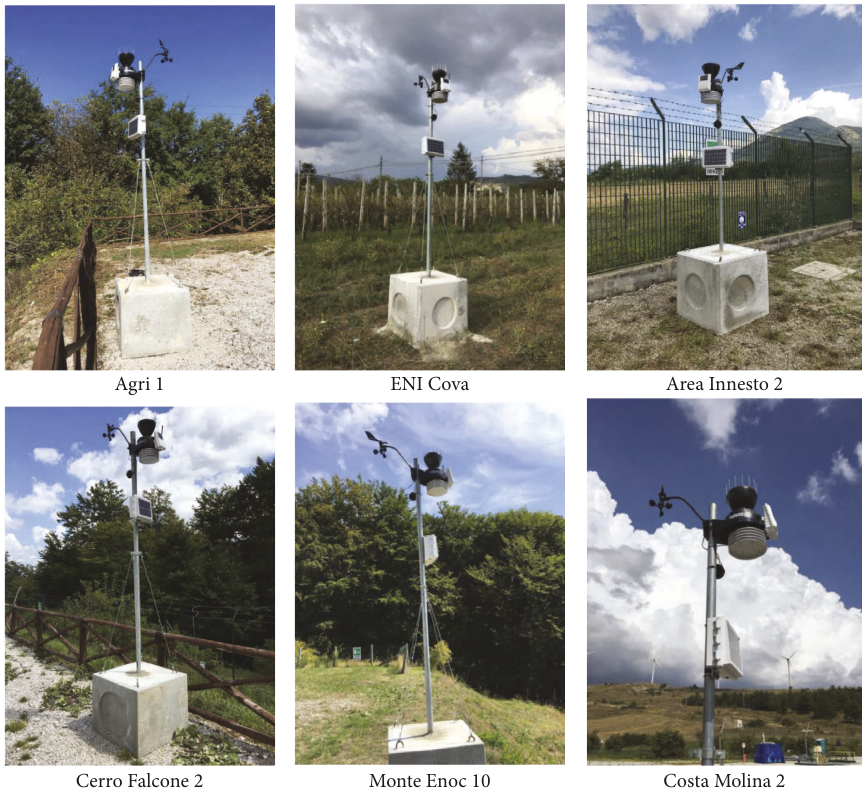
Figure 4: The six weather stations installed in the Val d’Agri basin by the Eni